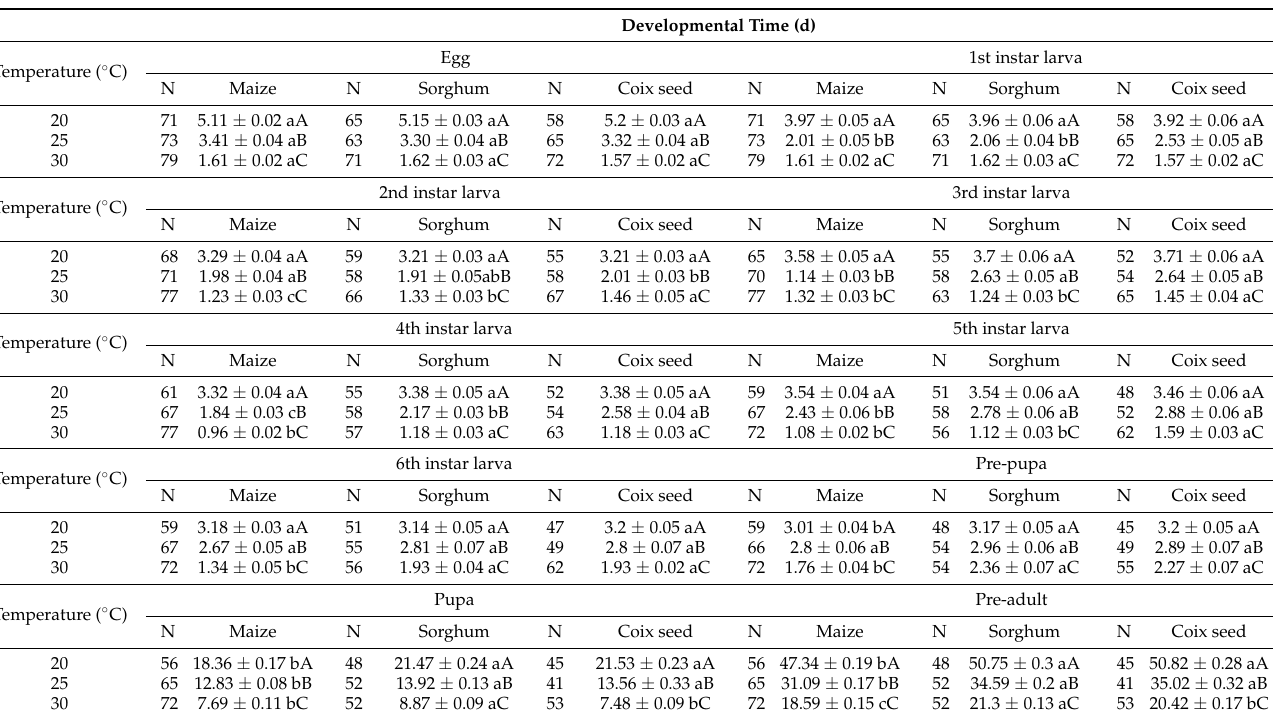
Table 2. Duration of the mean ( ± SE) each developmental stage of Spodoptera frugiperda reared on different host plants under different temperatures.